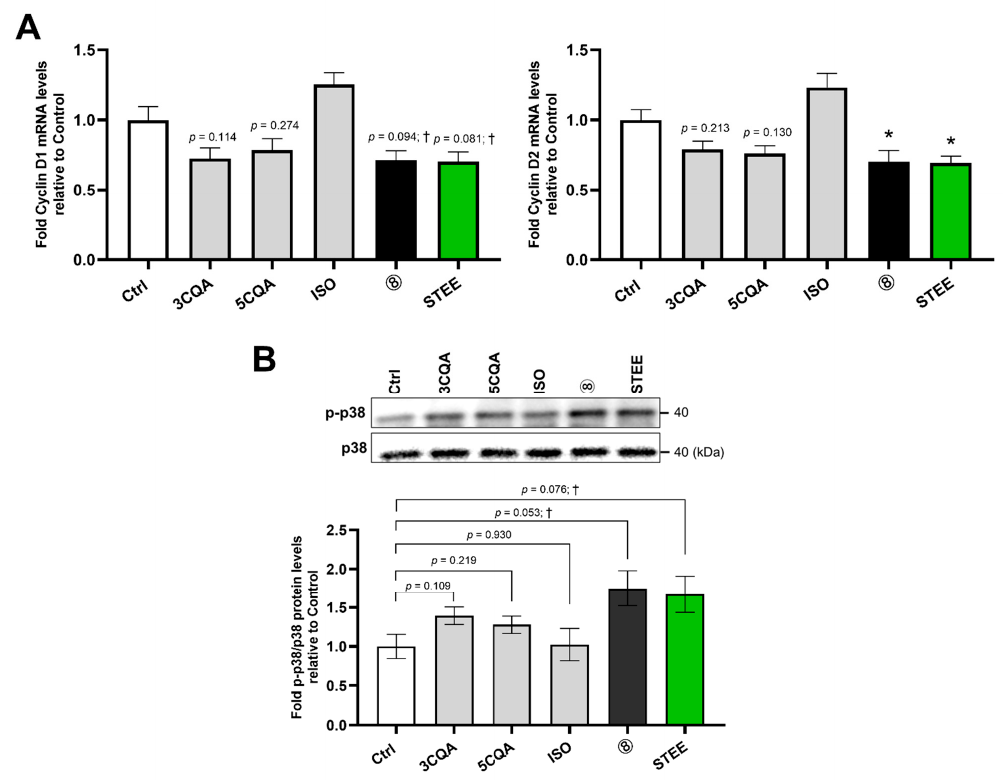
Figure 2. Mono-CQAs in STEE reduced Cyclin D mRNA expressions in hNSCs. ( A ) Cells were incubated with STEE and group 8’s compounds for 24 h, and Cyclin D1 and D2 mRNA ( CCND1 and CCND2 ) levels were measured by qRT-PCR. The relative values are the mean ± SEM (n = 3–4) compared with the control. One-way ANOVA with Dunnett’s post hoc test for the comparisons: * p < 0.05; † p < 0.1. ( B ) Cells were treated with STEE and group 8’s compounds for 60 min. The amounts of p-p38 and p38 were detected by immunoblotting, and band intensities were quantified. Data represent mean ± SEM (n = 3) when compared with control. Student’s t -test (unpaired) for the comparisons: † p < 0.1. A description of the number for the treatment group is indicated in Table